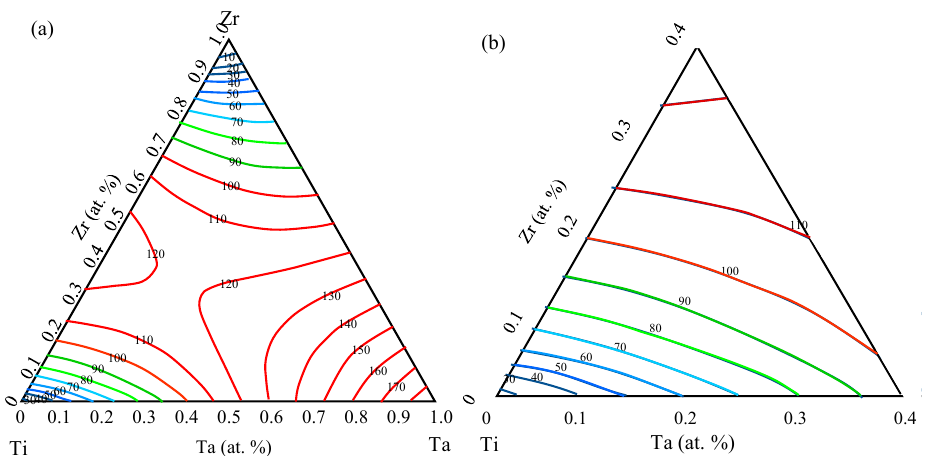
Figure 9. Calculating Young’s moduli ( a ) and Ti corner partial image ( b ) of TiZrTa ternary alloys with a pure beta phase